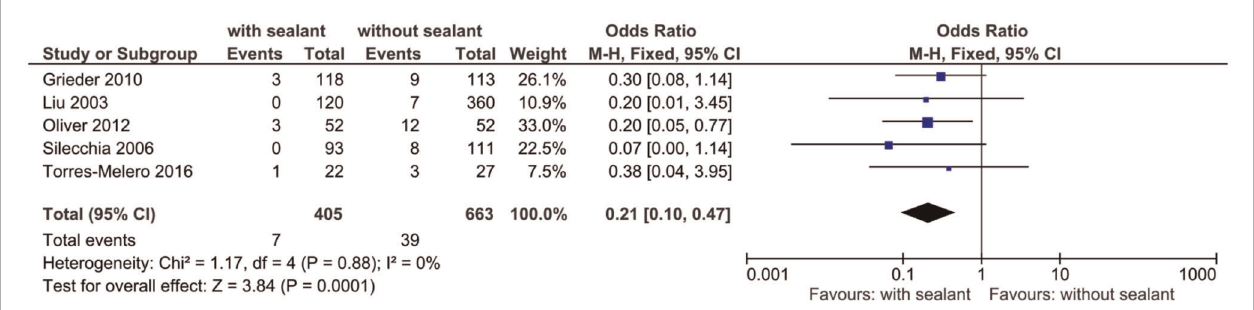
FIGURE 3 | Fixed-effects meta-analysis for the postoperative reoperation rate in the intervention (coated or reinforced anastomoses) and control group. The forest plot of all studies is